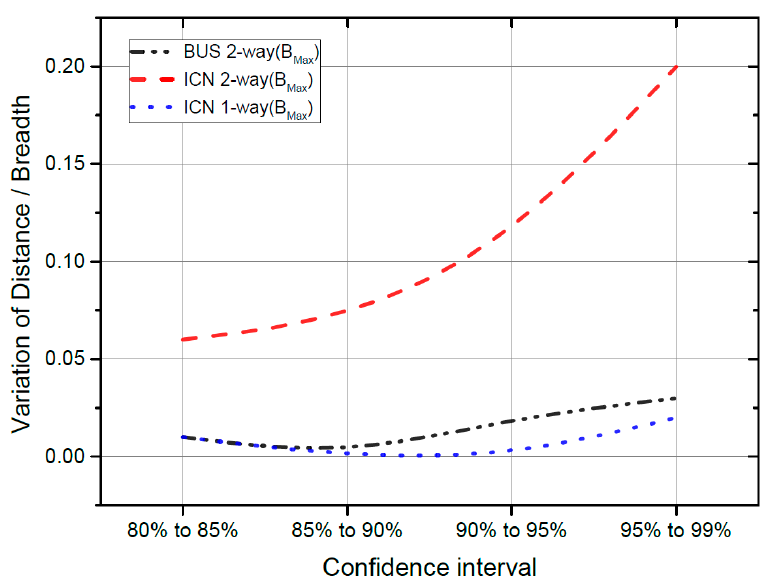
Figure 16. Variation of distances differences divided by the ship’s maximum breadth. Table 15. Data for variation of distances differences divided by the ship’s maximum breadth.